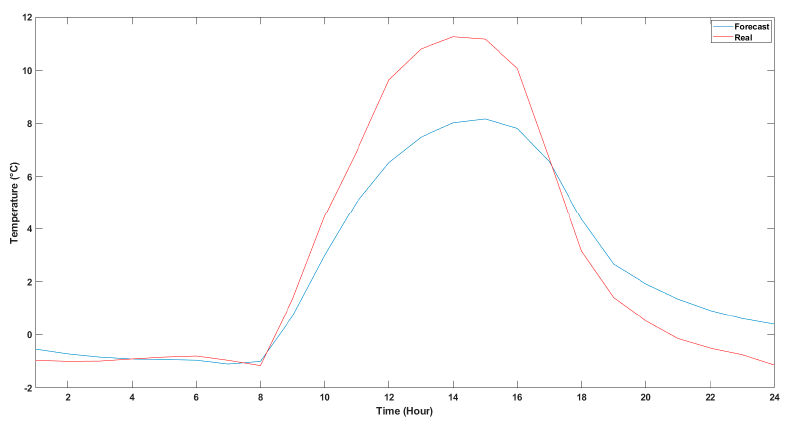
Figure 11. Forecasting and real temperature curves for 04/02/2019. Table 9. Statistical performance measures for temperature.